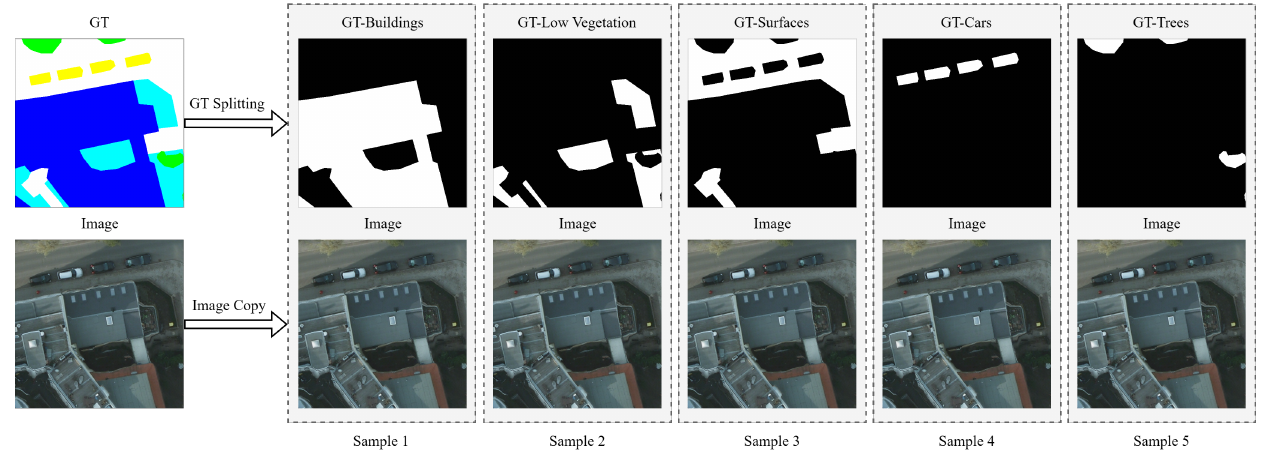
Figure 10. Visualization of the process of constructing a sample set with image truth